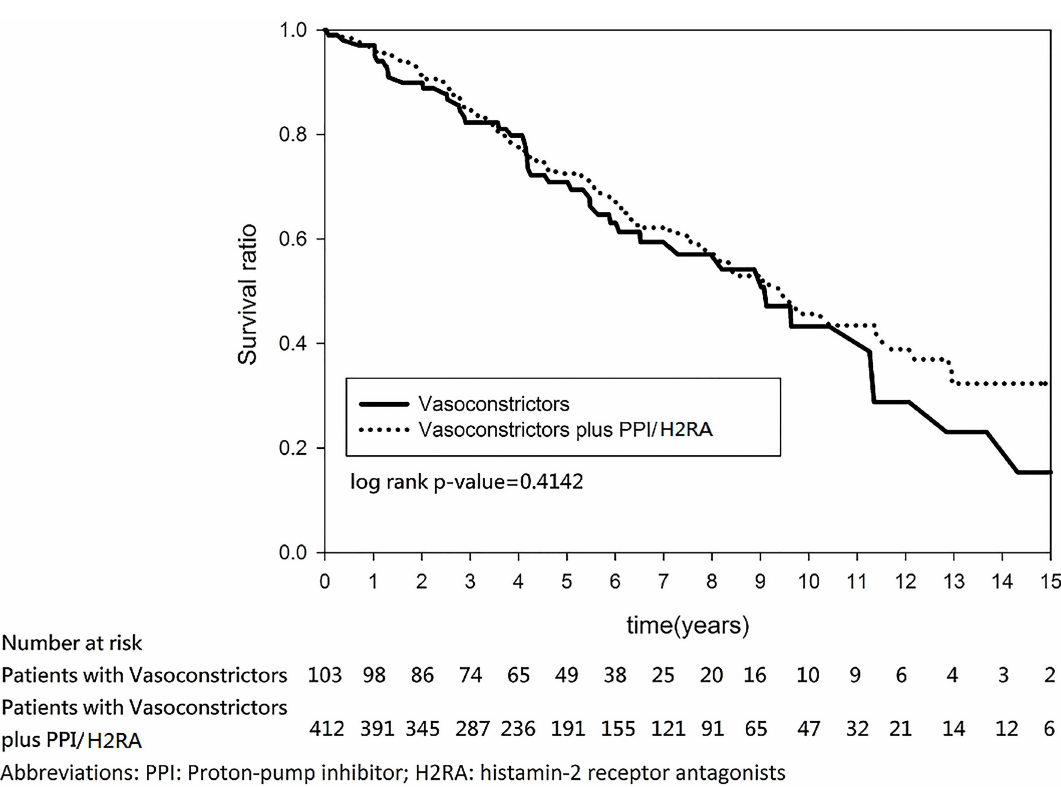
Fig 5. Kaplan–Meier estimatesof survival in patients with cirrhosis and esophageal varicealbleeding (15 years follow-up).